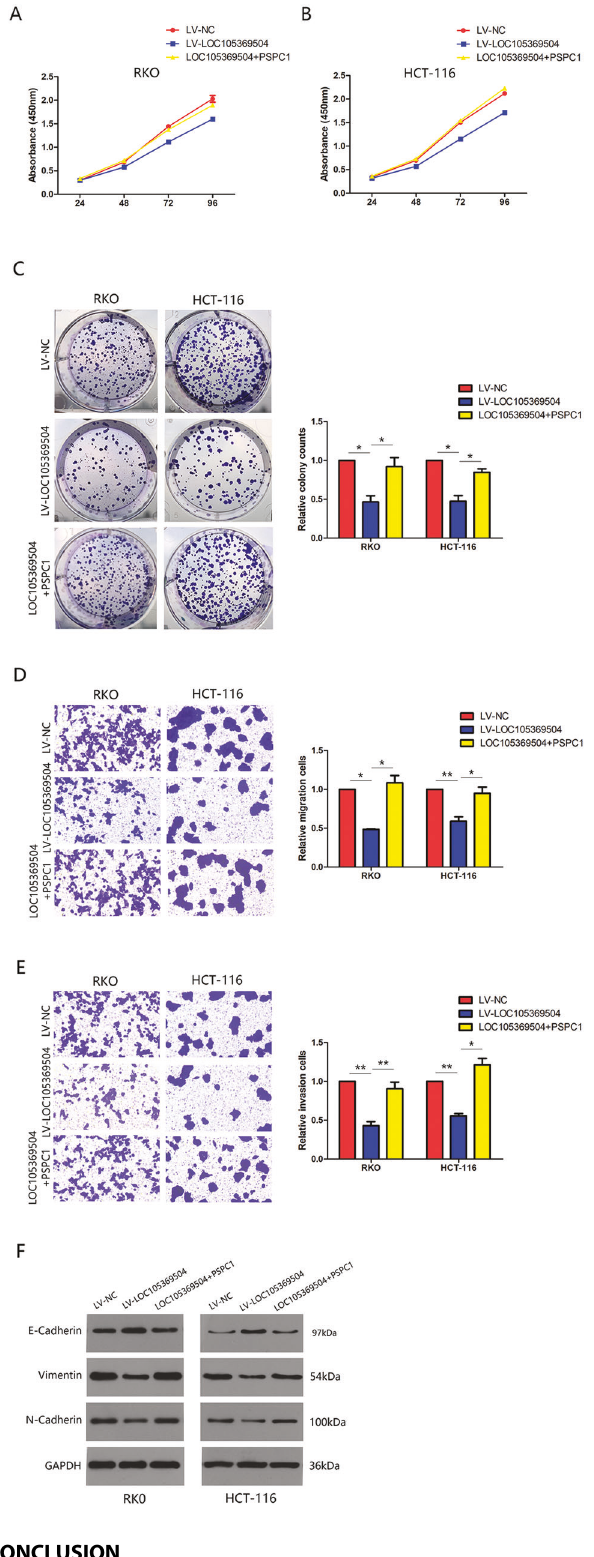
Fig. 4 LOC105369504 suppressed tumor proliferation and metas- tasis in a PSPC1-mediated manner. A , B The cell proliferation of RKO and HCT-116 cells transfected with LV-LOC105369504 or LV- LOC105369504 plus the PSPC1 expression vector. C Colony forma- tion assays for CRC cells transfected with LV-LOC105369504 or LV- LOC105369504 plus the PSPC1 expression vector. D , E Transwell assay for CRC cells transfected with LV-LOC105369504 or LV- LOC105369504 plus the PSPC1 expression vector. F The EMT- associated genes were identi fi ed through western blotting in CRC cells transfected with LV-LOC105369504 or LV-LOC105369504 plus the PSPC1 expression vector. All data are expressed as the mean ± SD. * p < 0.05, ** p <